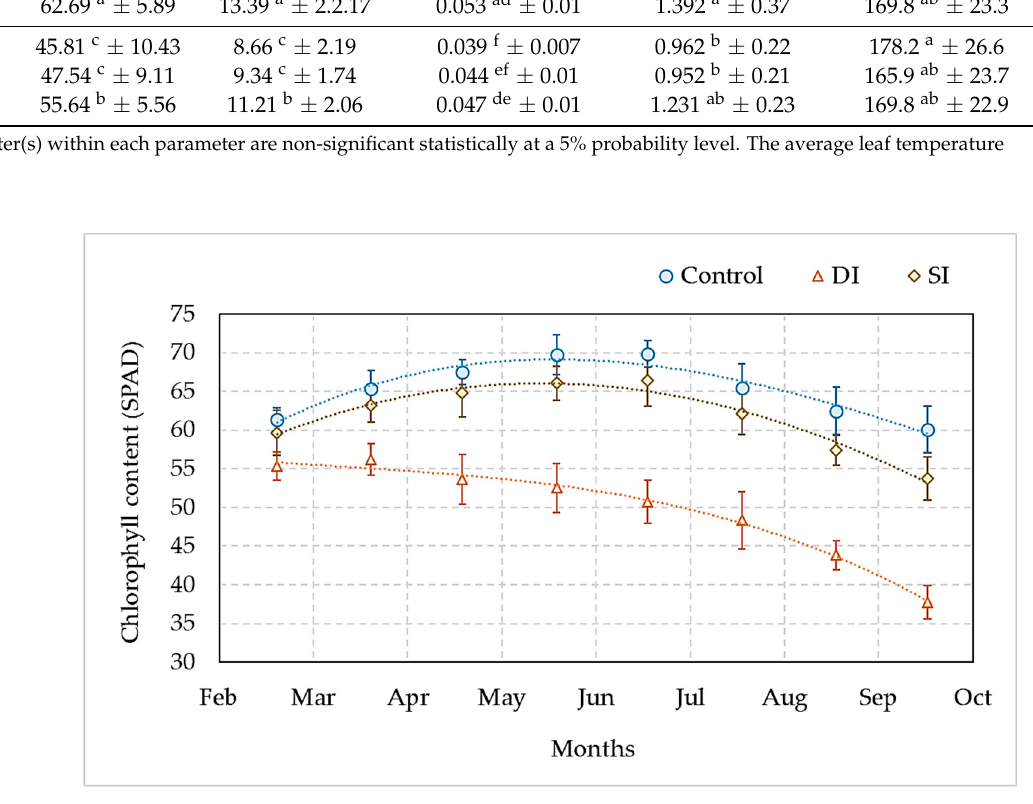
Figure 7. Effect of drip irrigation (DI), subsurface irrigation (SI), and bubbler irrigation (control) systems on chlorophyll content of date palm (Khalas cv.). Each data point for SI and DI systems represents an average of 50, 75, and 100% ETc levels, whereas it is at 100% ETc level for control during 2020–2021.